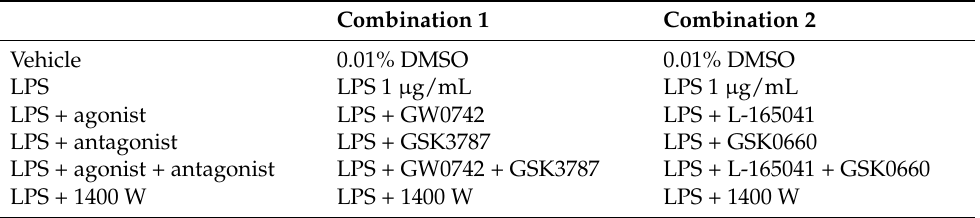
Table 3. Treatments of tissues with two different combination types of agonists and